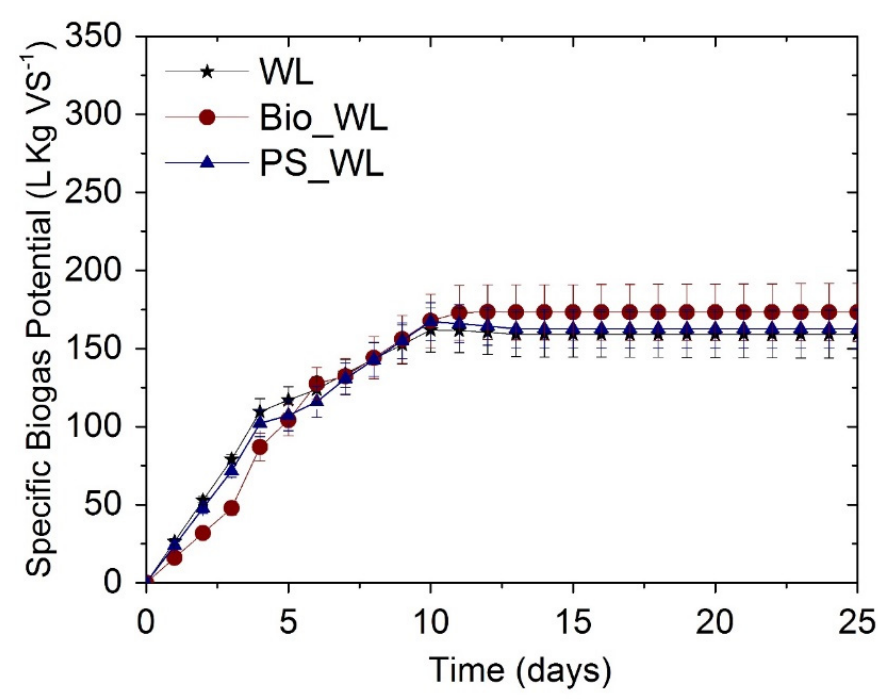
Figure 5. Cumulative specific biogas potential measured for wine lees with biochar (Bio_WL) and pumice stone (PS_WL) and comparison with wine lees (WL). Table 6. Kinetic parameters obtained from fitted data to the Gompertz model. Results from batch AD tests of WL with biochar and pumice stone.